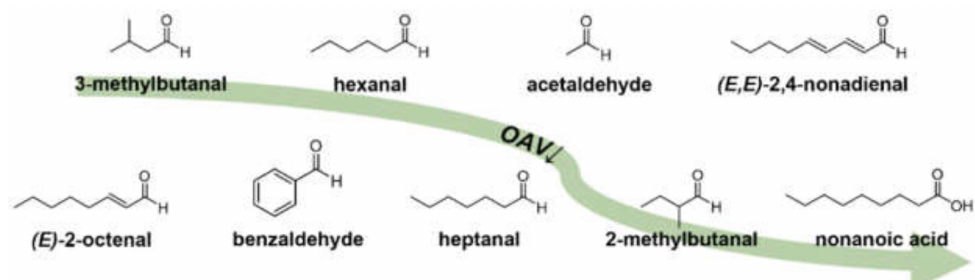
Figure 6. Chemical structures of KFO in pea protein ( Pisum sativum L.) in descending OAV order, revealed by means of 3-AFC omission and OAV